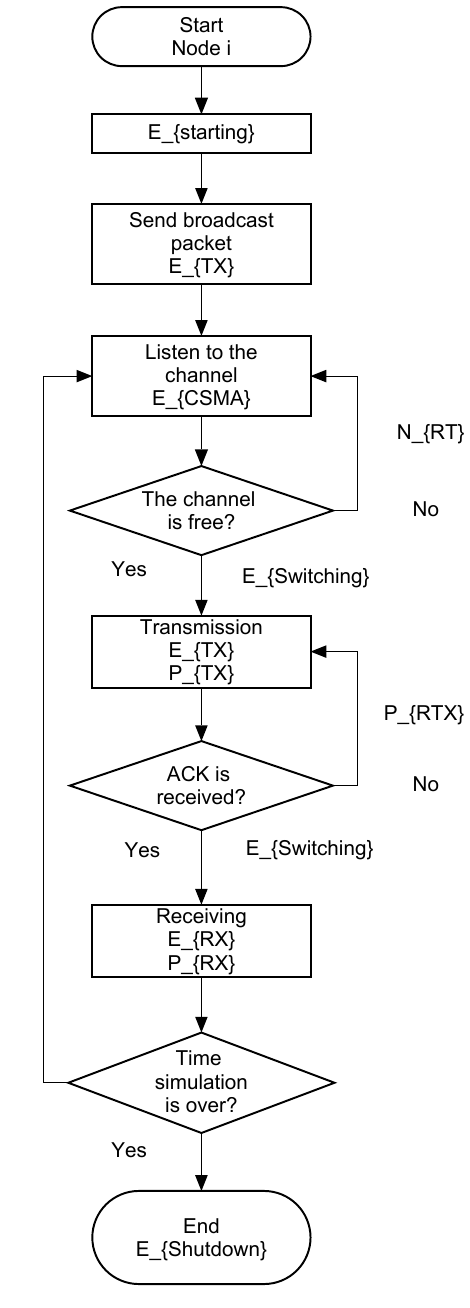
Figure 16. Flowchart scheme of the energy model for node i